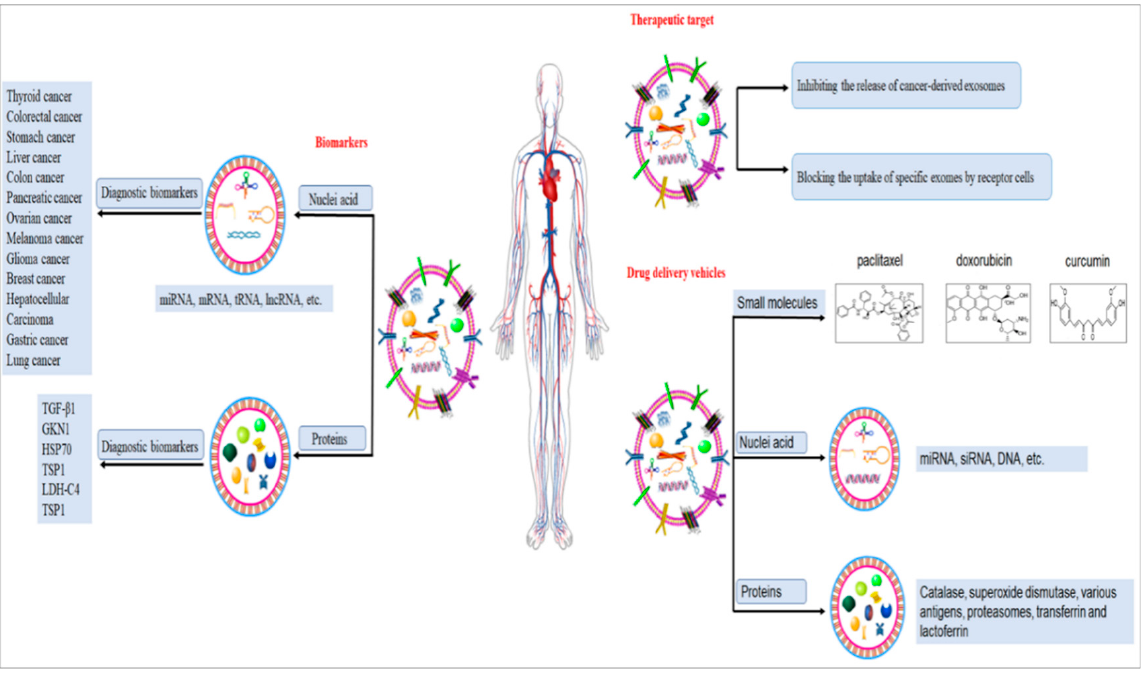
Figure 4. The applications of exosomes in cancers.